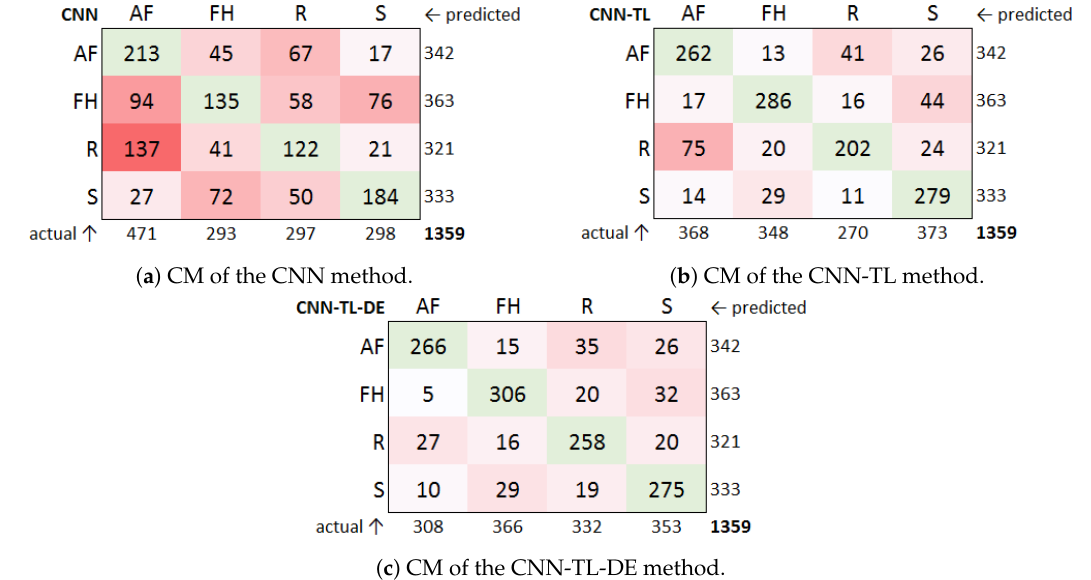
Figure 6. Comparison of confusion matrices of the three methods on test data (AF, American football; FH, field hockey; R, rugby; S,